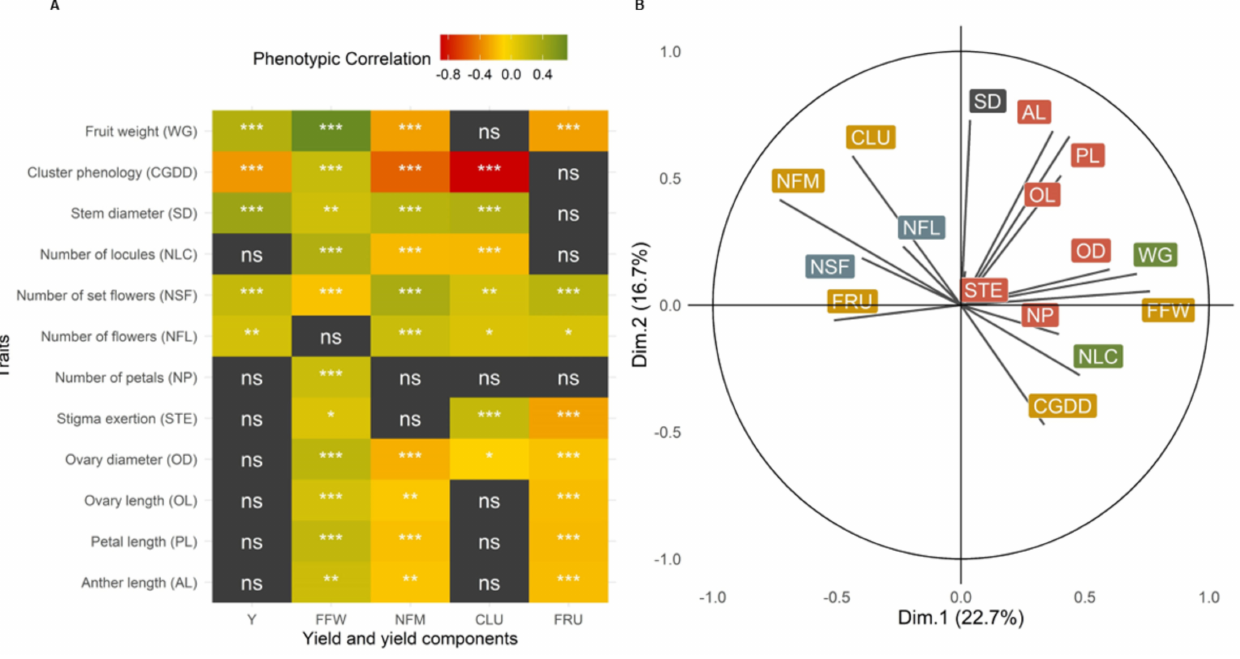
Figure 5. Correlation of reproductive traits and yield components. ( A ): Spearman correlation coeffi- cient heatmap. Significance of the correlation *: p -value ≤ 0.05; **: p -value ≤ 0.01; ***: p -value ≤ 0.001, grey: not significant (ns); ( B ): Correlation circle of the principal components of the traits, yield not included. Colors differentiate traits of flowers (red), inflorescences (blue), fruits (green), and plants